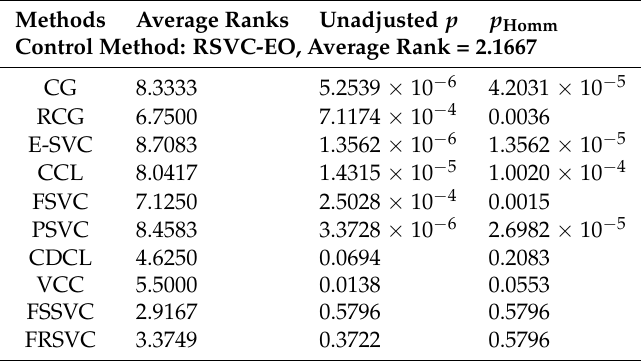
Table 4. Comparison under non-parametric statistical